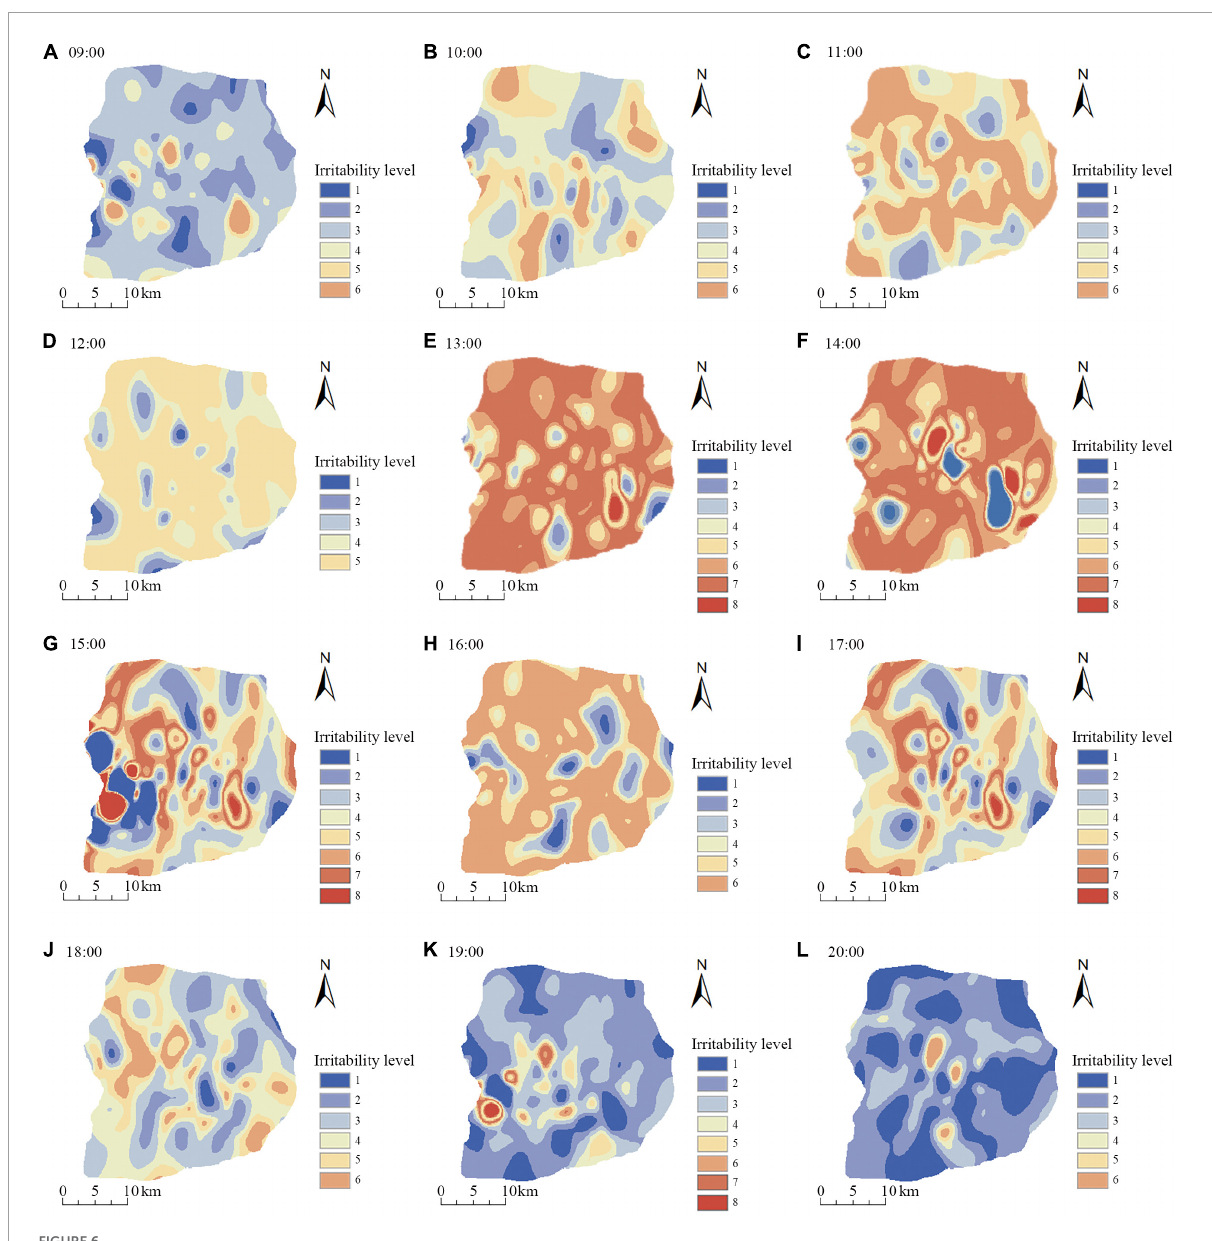
FIGURE6 Evolution of spatiotemporal pattern of urban heat island (UHI)’s influence on irritability from 09:00 to 20:00.